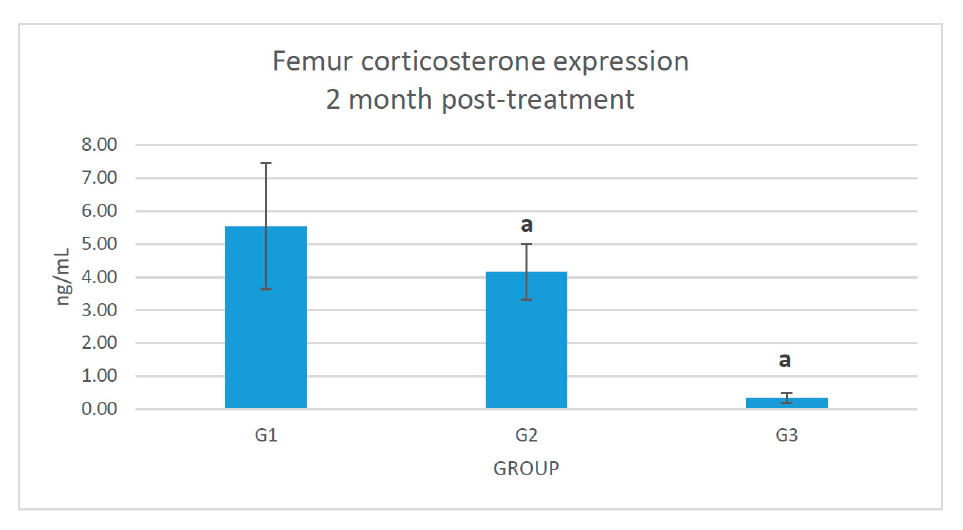
Figure 2. The effect of femoral corticosterone expression in G1: sham-operated control; G2: adrenalectomized (adrx) control given intramuscular dexamethasone (DEX) 120 μ g/kg/day; and G3: adrx and given intramuscular DEX 120 μ g/kg/day and Piper sarmentosum 125 mg/kg/day. Identical letter (a) indicates significant difference between groups at p < 0.05.